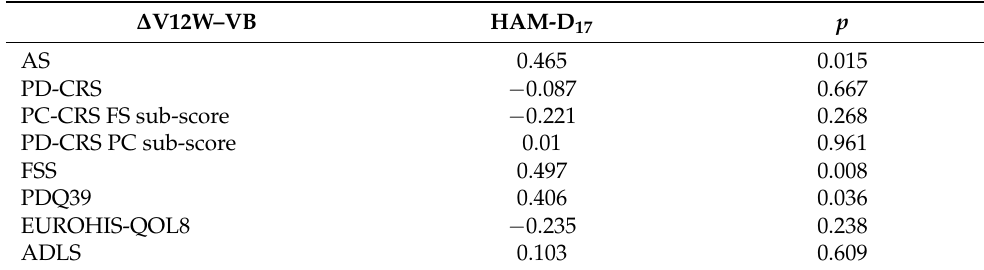
Table 3. Correlation between the change in the HAM-D 17 total score from VB to V12w ( ∆ V12w–VB) and the change in the score in other scales from VB to V12w.